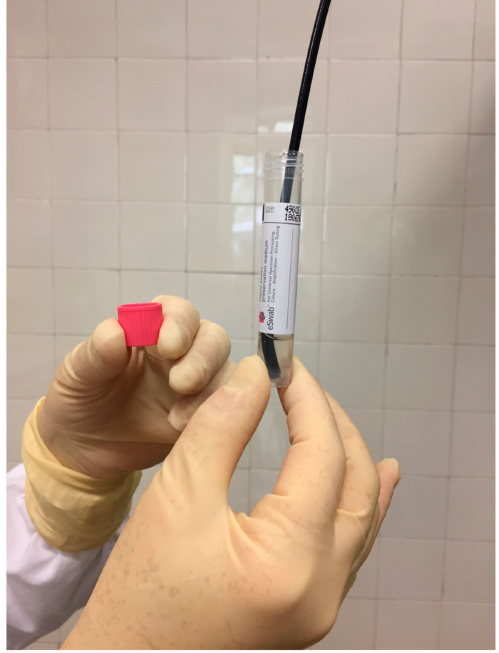
Figure 1. Sampling after the patient’s